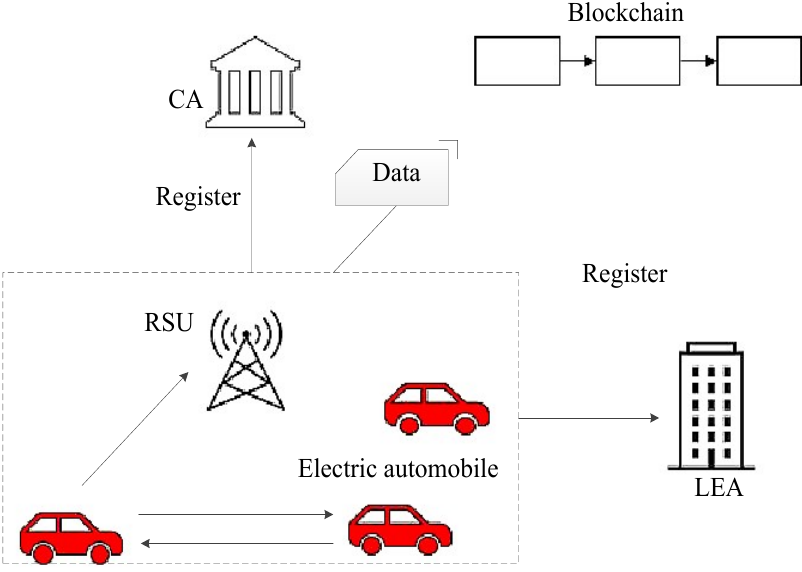
Figure 2. Electric vehicle networking system model.